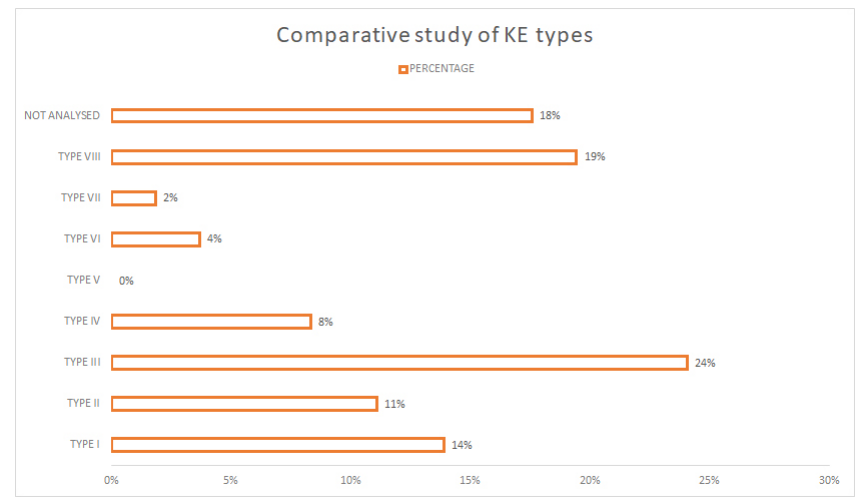
Figure 8. Comparative study of KE types.